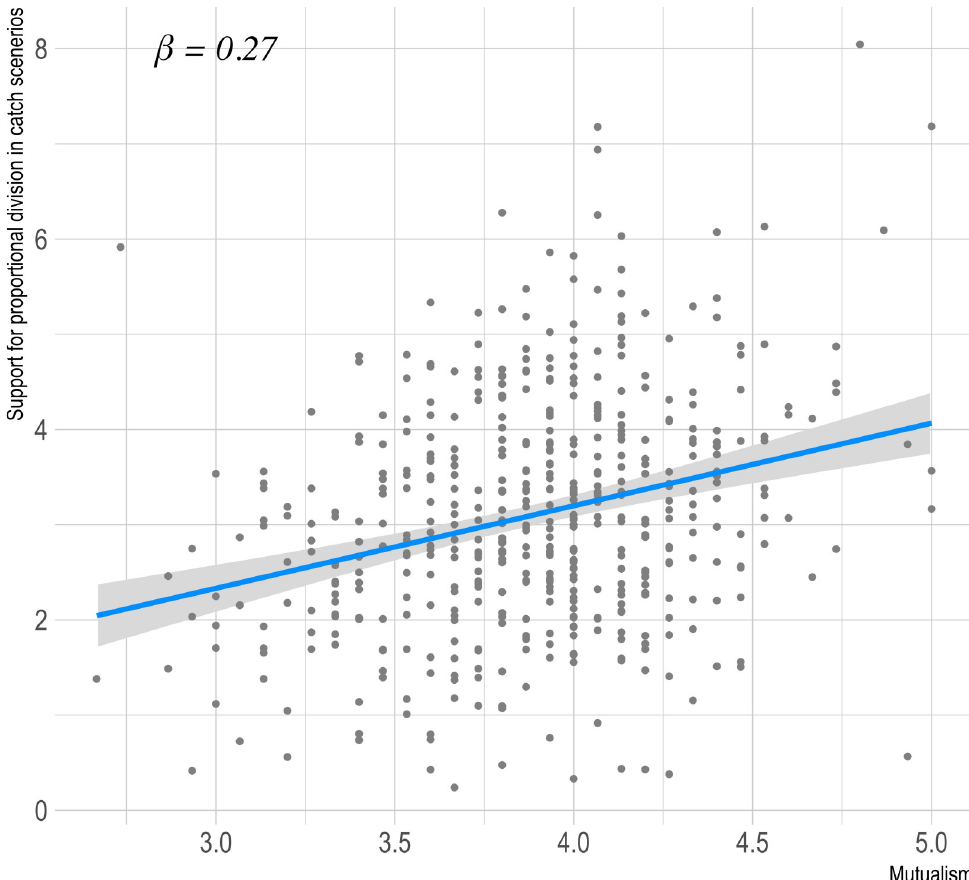
Fig 5. Association of mutualism with proportional catch-sharing scenario sum (Study